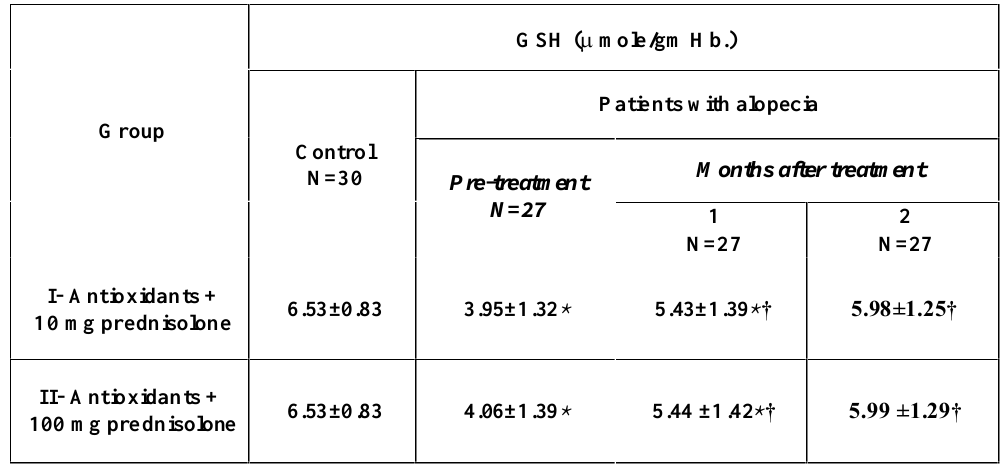
Table (4): Effect of the addition of nutrient antioxidants (A, E, andC) to prednisolone therapy